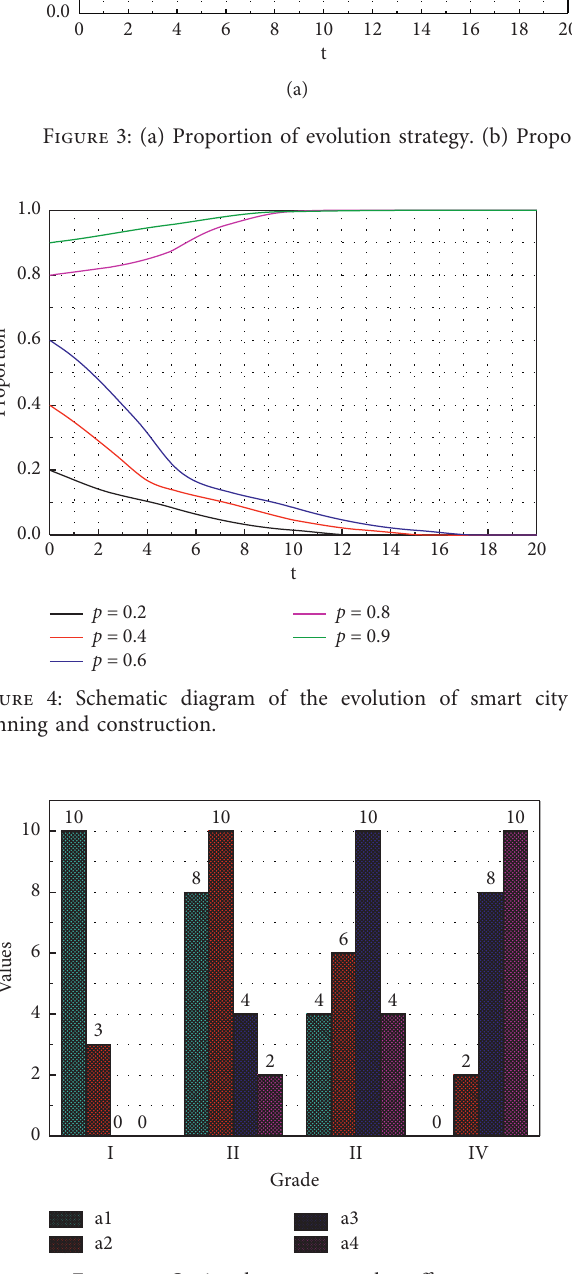
Figure 5: Optional emergency plan effect.